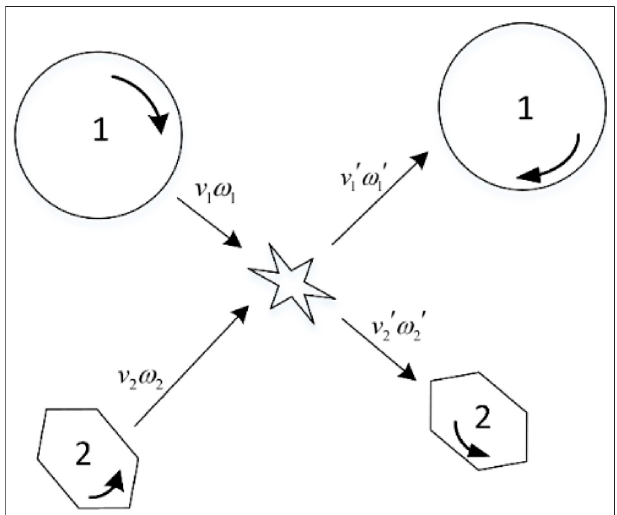
FIGURE 5 | Collision of liquid metal particles and abrasive